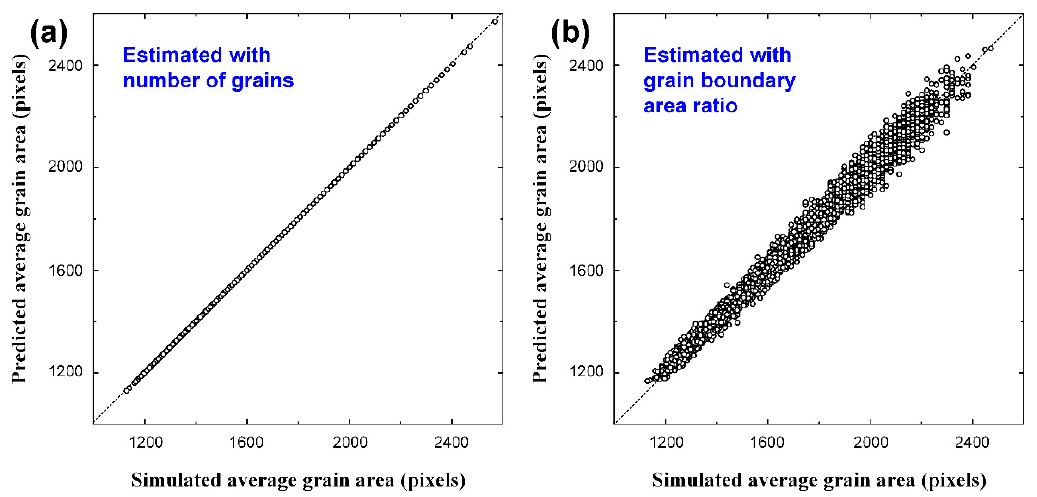
Figure 3. Average grain sizes estimated with ( a ) number of grains, and ( b ) ratio of grain boundary area in the simulated grains, based on Equations (1) and (2), respectively.